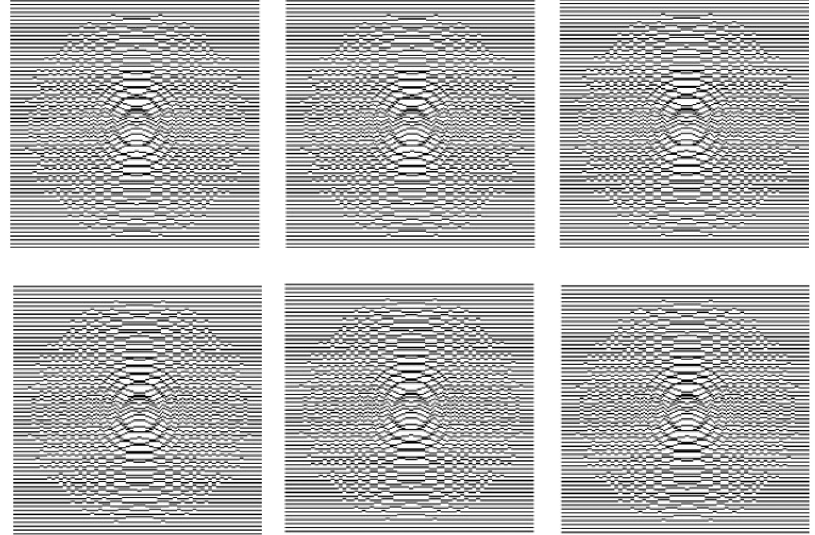
Figure 6.3 . Evolution of the intensity of the vortex solutions (6.4), (6.5), and (6.6) in dynamics of VNSE (6.2). Stable propagation on distance π is estab- lished.